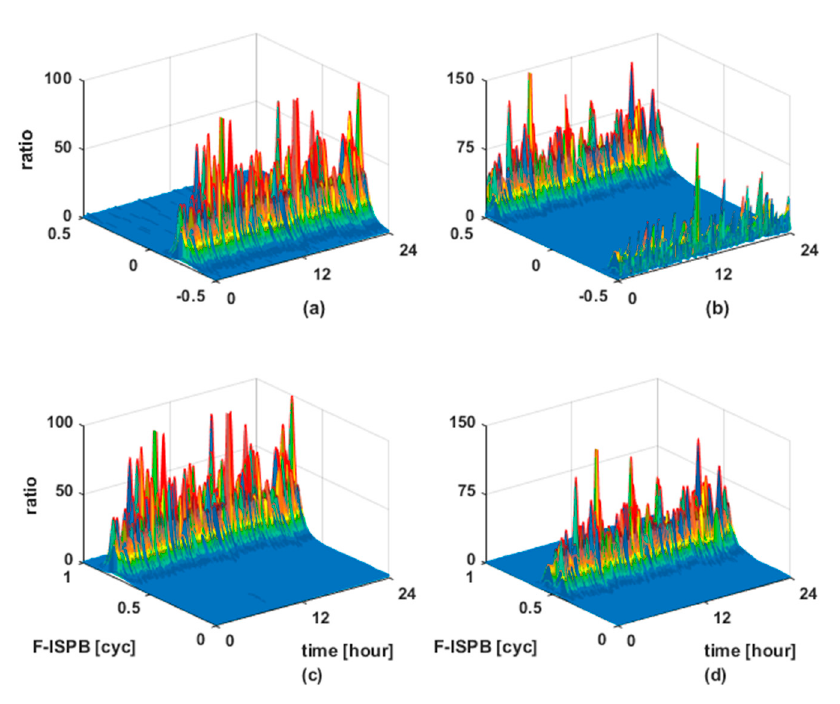
Figure 2. Relationship between ratio and F-ISPB for all epochs. ( a , c ) CUTB–CUTC. ( b , d ) CUTB–